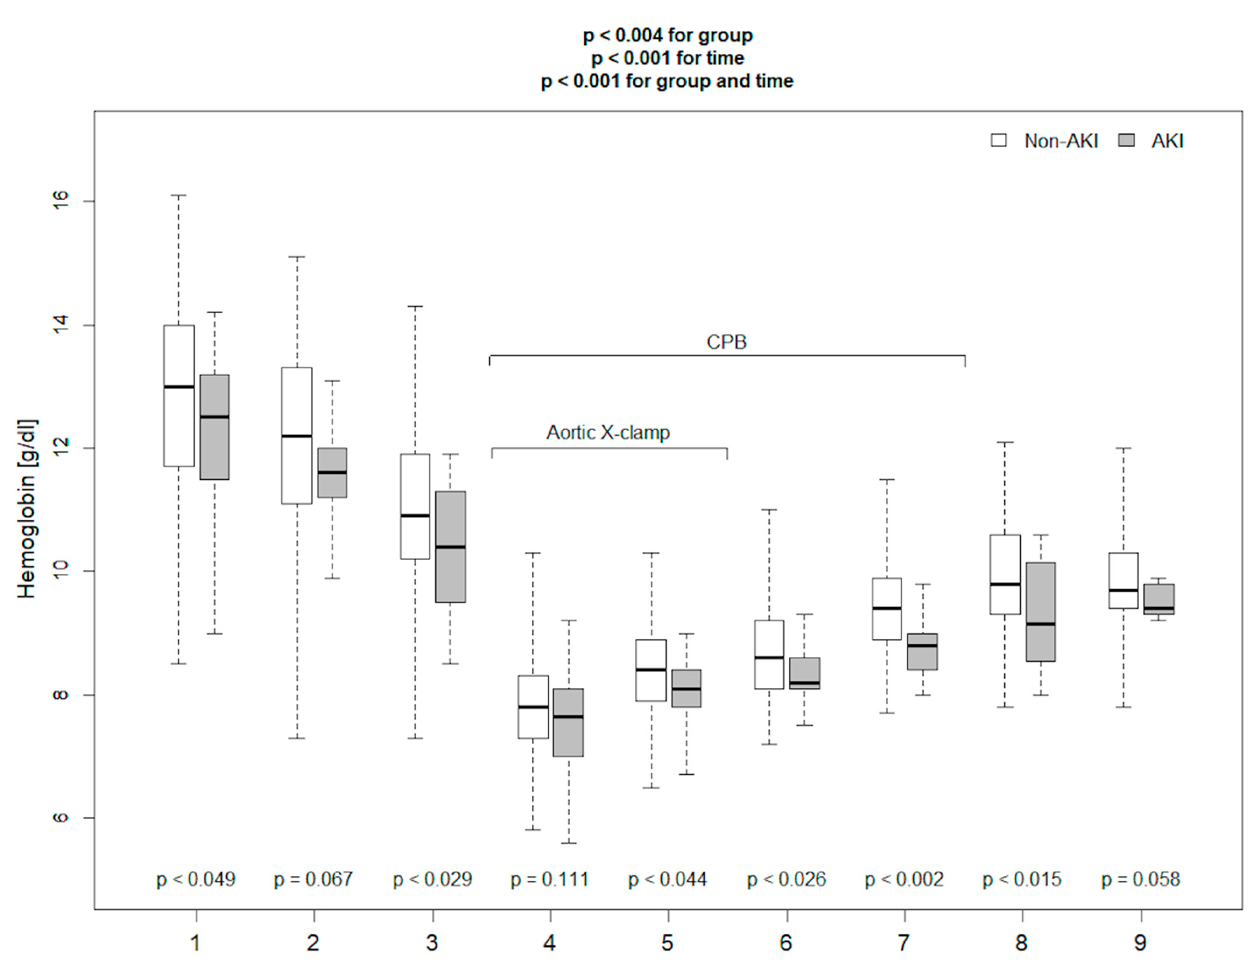
Figure 1. Haemoglobin concentration measured in the operating room (with p values for comparison between AKI and non-AKI patients at following time points). {1}—before anaesthesia induction, {2}—directly before skin incision, {3}—after sternum opening, {4}—20 min after aortic cross-clamping, {5}—40 min after aortic cross-clamping, {6}—20 min after aortic cross-clamp removal, {7}—20 min after weaning from CPB, {8}—40 min after separation from CPB, {9}—60 min after separation from CPB.